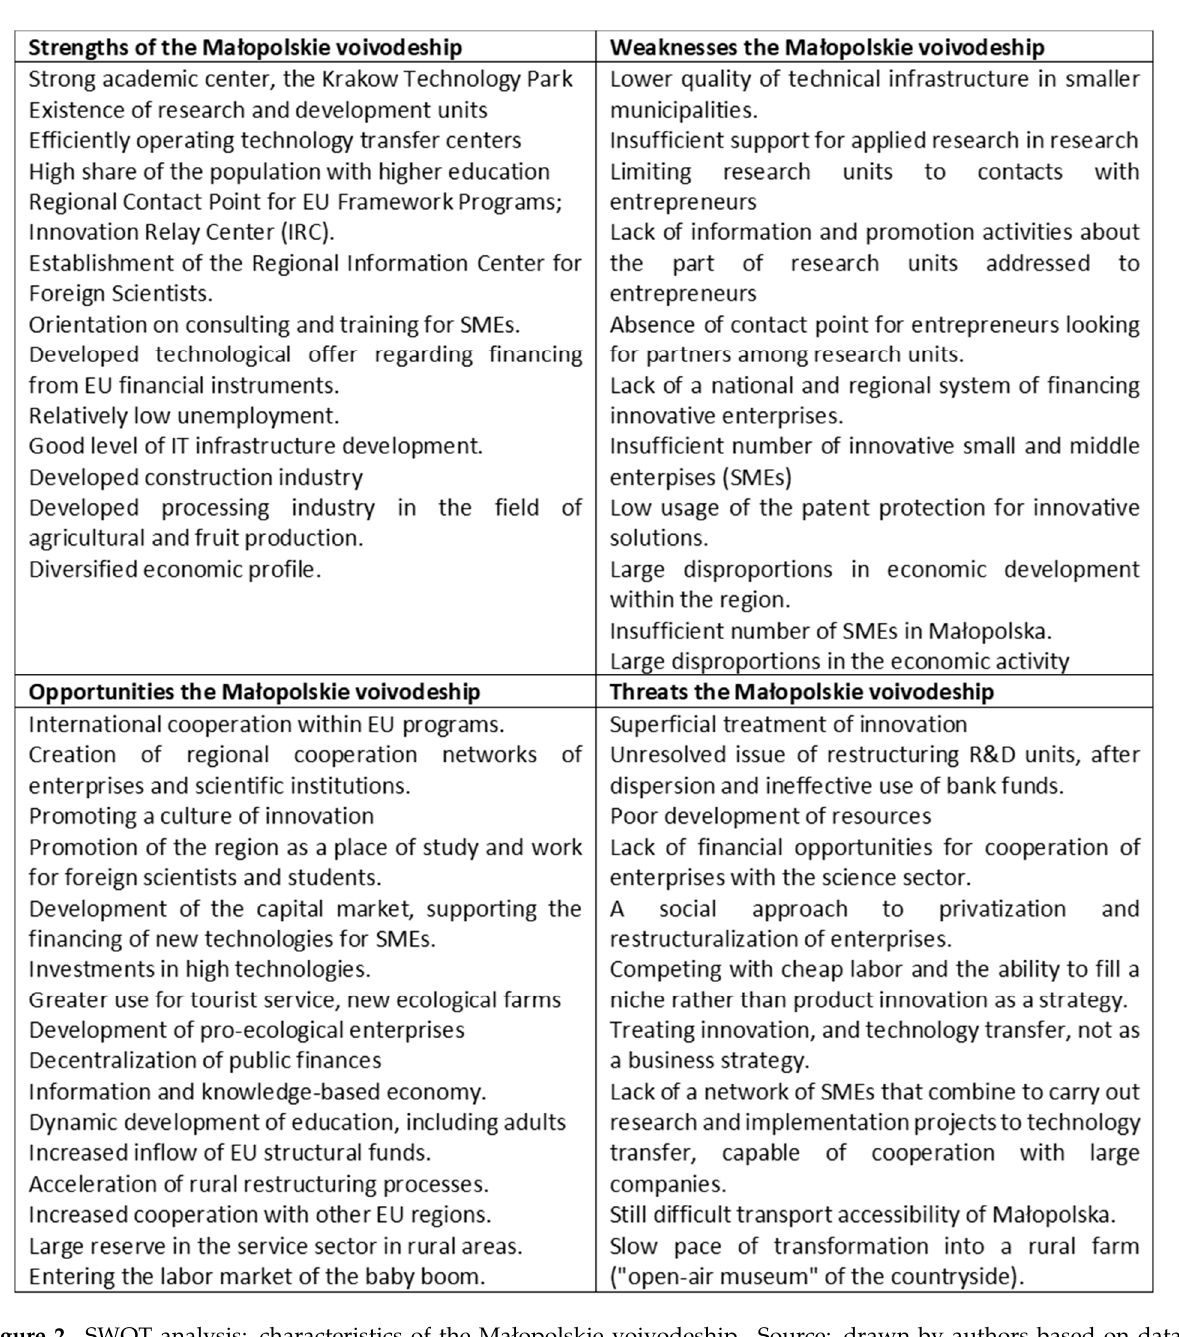
Figure 2. SWOT analysis: characteristics of the Małopolskie voivodeship. Source: drawn by authors based on data from [36–39].